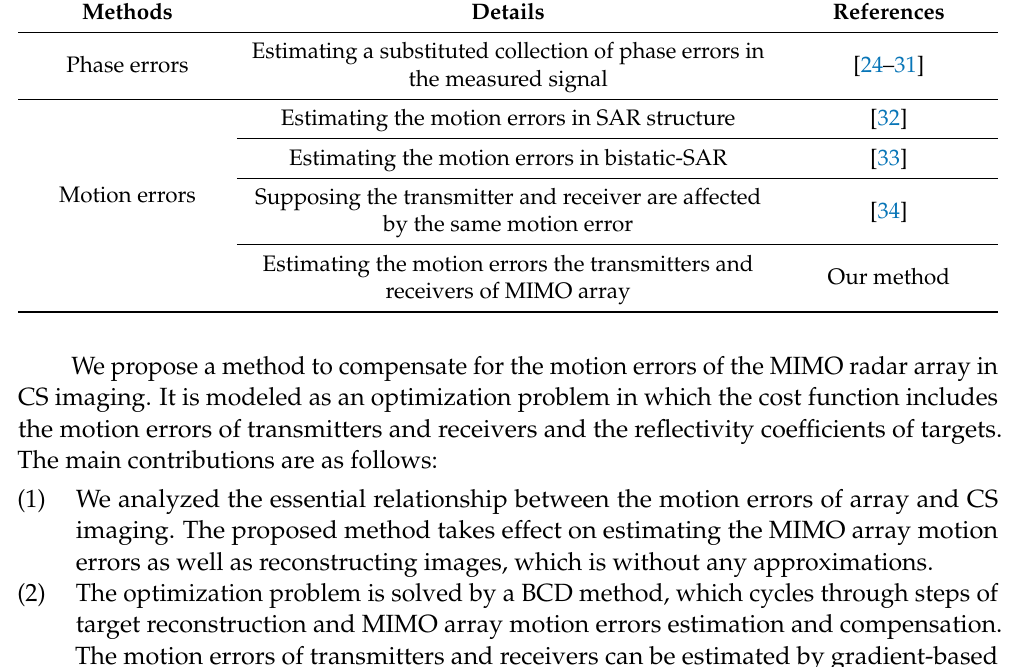
Table 1. Categories of methods to solve autofocus problems.